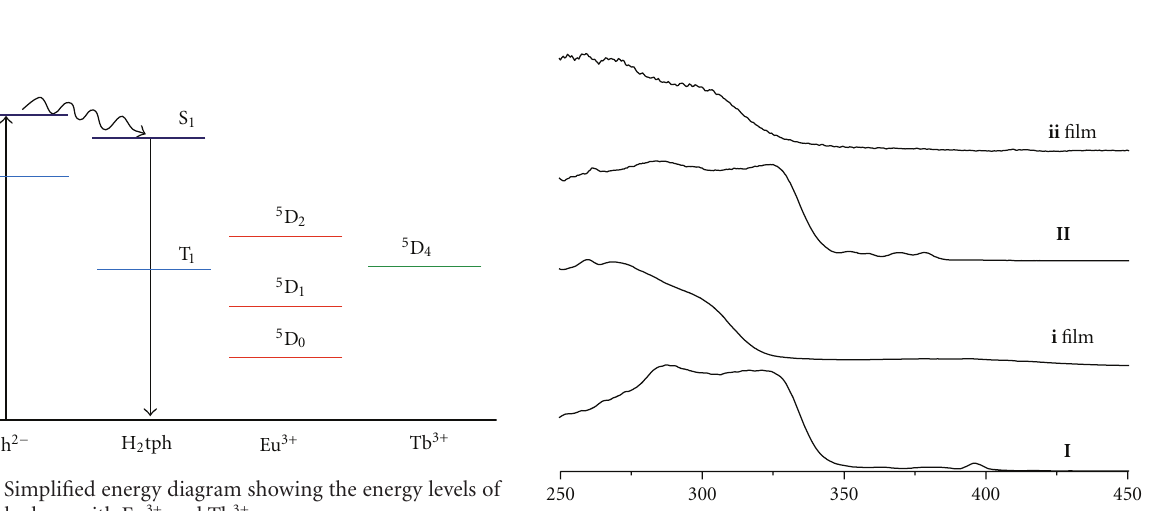
Figure 9: Normalized (a) excitation spectra of Tb 2 (tph) 3 (H 2 O) 4 (II) , ii film, ii film annealed, and Tb(dpm) 3 ( λ em = 545 nm), and (b) emission spectra of ii film and ii film annealed ( λ ex = 280 nm).